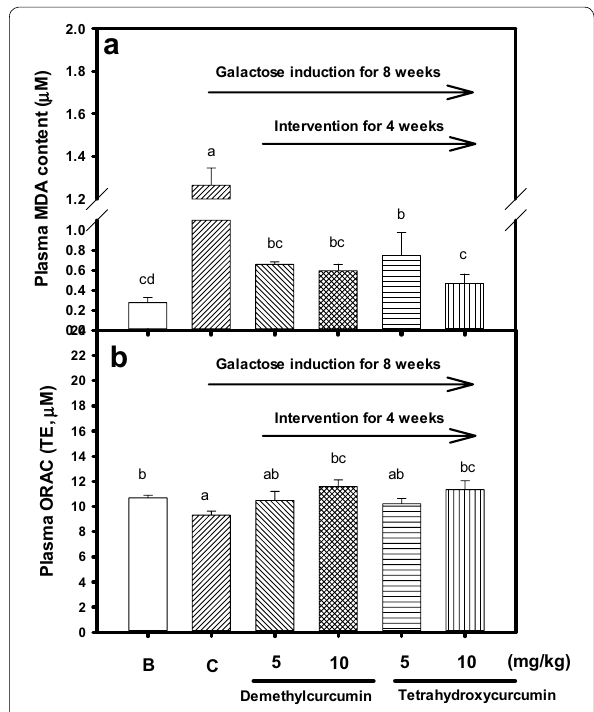
Fig. 3 Effects of demethylcurcumin or tetrahydroxycurcumin interventions (5 and 10 mg/kg) on a plasma MDA contents, and b plasma ORAC activities in d ‑galactose‑induced mice. Values were presented as mean SD and were analyzed using one‑way ANOVA, ± followed by a post hoc Tukey’s test for multiple comparisons. The P < 0.05 was considered statistically significant and marked on the column with different letters among